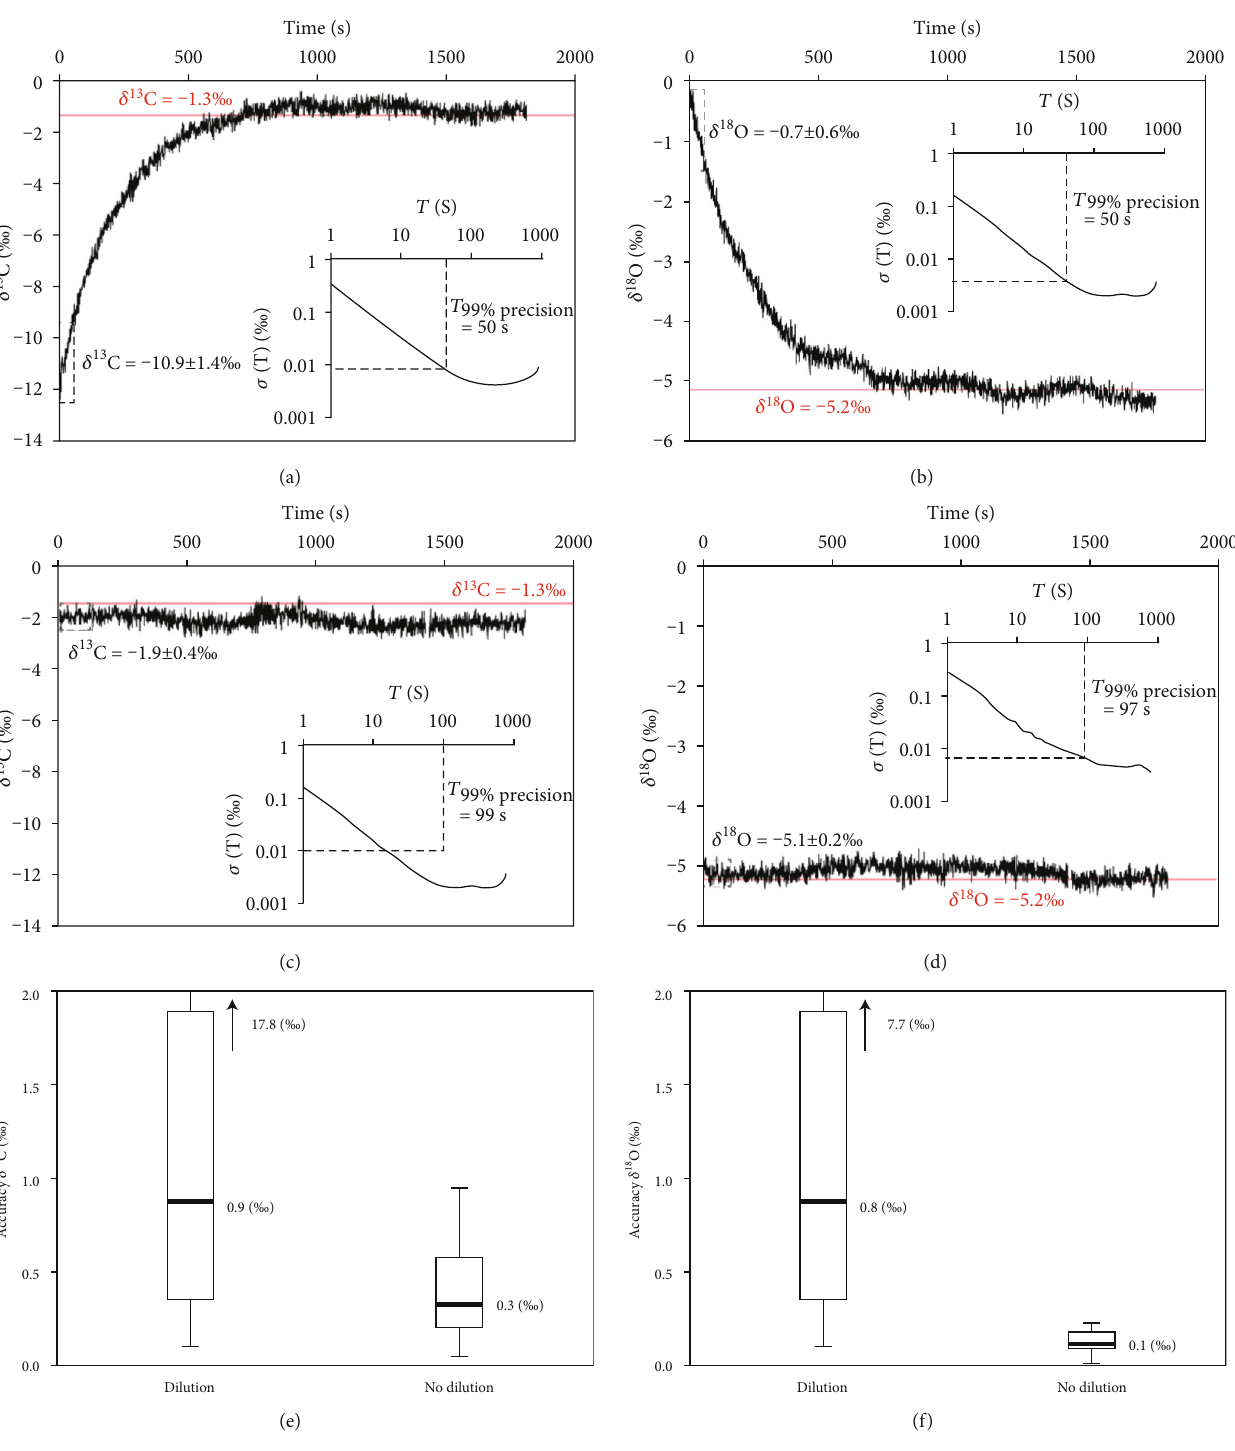
Figure 2: Raw signal (1 Hz) and overlapped Allan deviation obtained for 1800 s using a fi xed range dilution system (yellow tube) for δ 13 C (a) and δ 18 O (b) and without a dilution system for δ 13 C (c) and δ 18 O (d). Red values and lines represent the theoretical signal expected from the analyzed sampling bag. Dashed square represents the subset of measurements (on a time τ required to obtain 99% of the precision) used to calculate the average value used for the test of accuracy. Box-and-whisker plots for the deviations of δ 13 C (e) and δ 18 O (f) measured values from theoretical values of reference gases used in this study (see Methods and Appendix